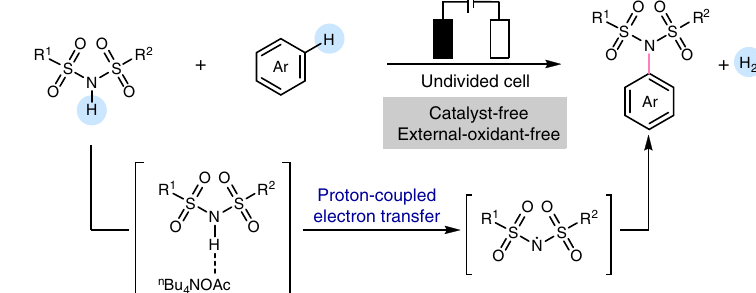
Fig. 1 C – N bond formation via radical addition of N -centered radical to unsaturated bonds. a Aryl C – N bond formation based on N -centered radicals. b Electrochemical-induced intramolecular C – N bond formation. c Our work: intermolecular aryl C – H imidation of simple arenes and